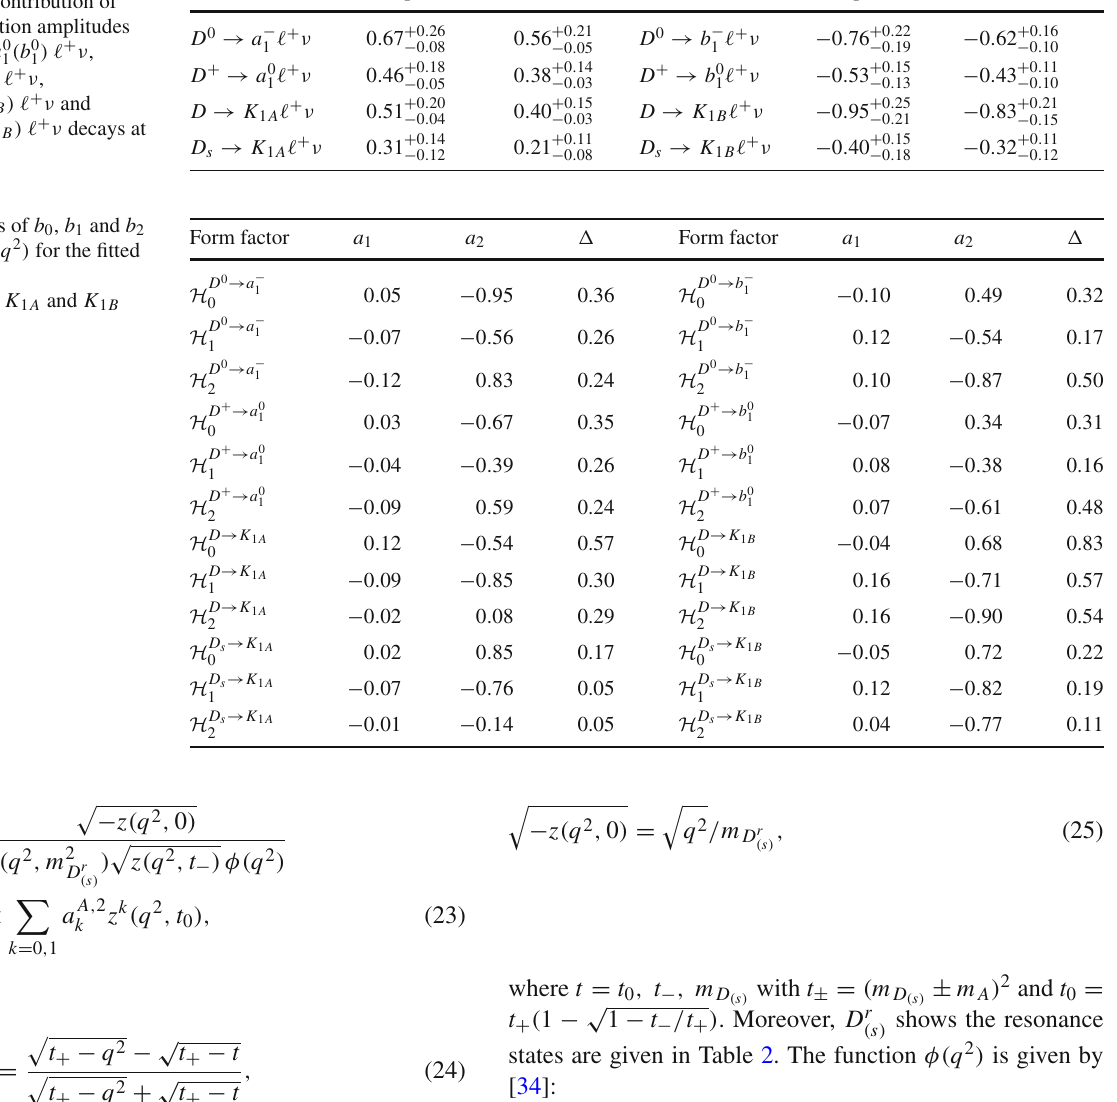
Table 3 Helicity form factor H 0 as well as contribution of twist-2 distribution amplitudes of the D + → a 0